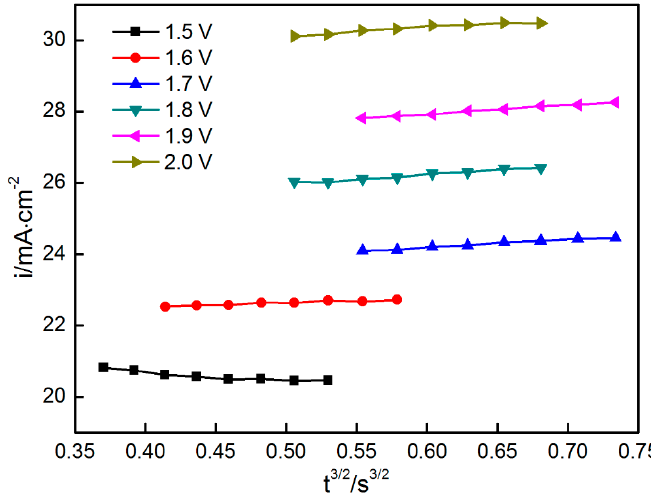
Figure 6. i – t 3/2 relationship when the potential was changed from 1.5 V to 2.0 V.